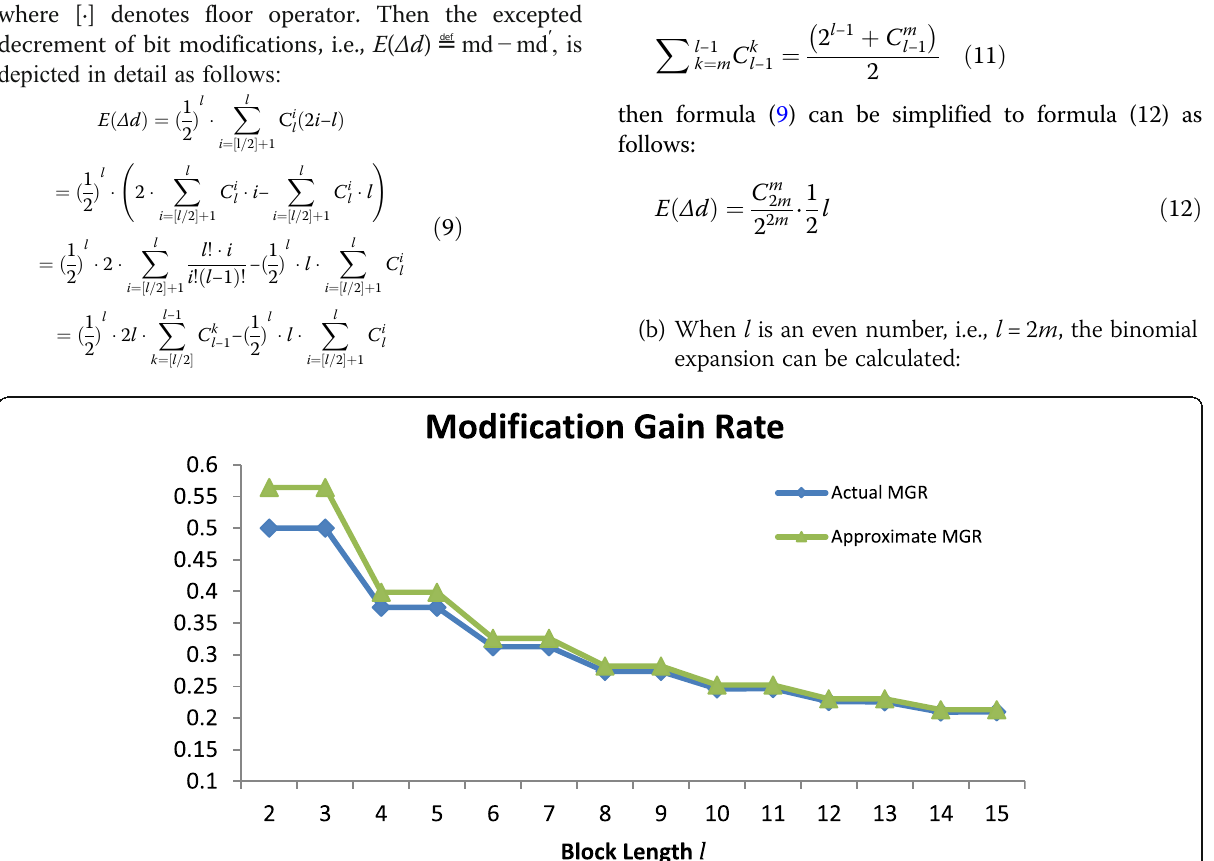
Fig. 10 Modification gain rate